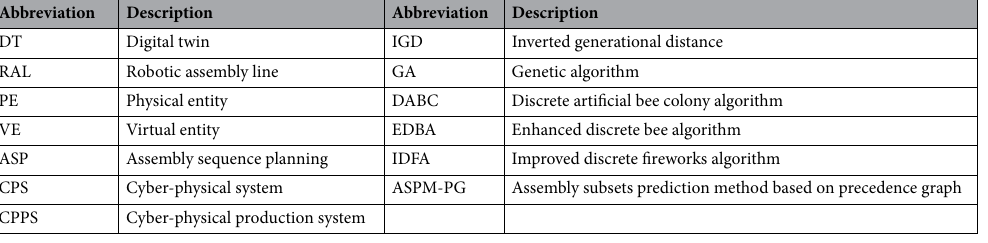
Table 1. Abbreviations